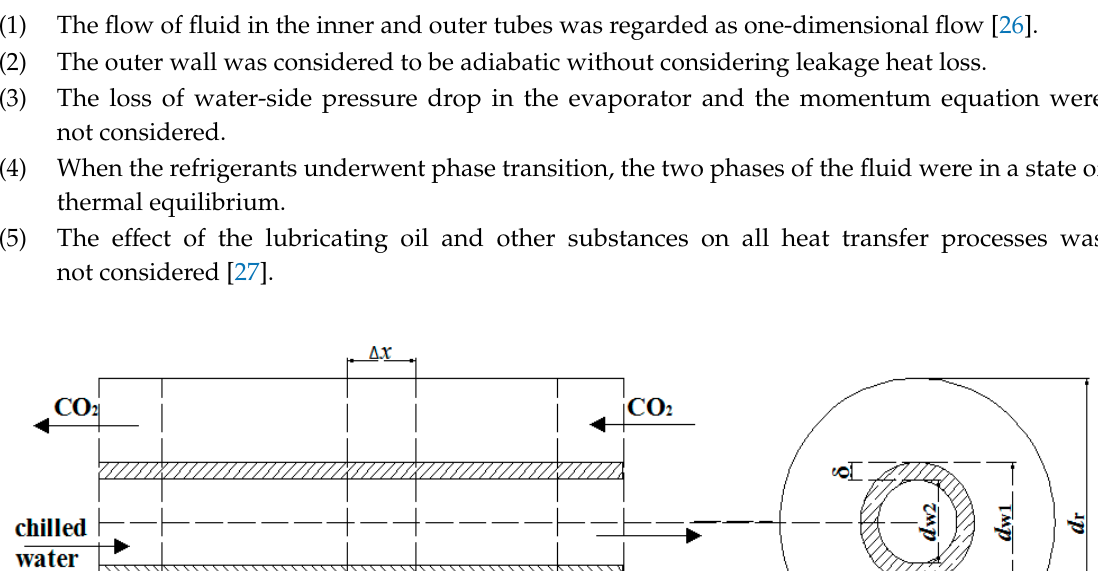
Figure 7. Effect of heat flux on cooling capacity.